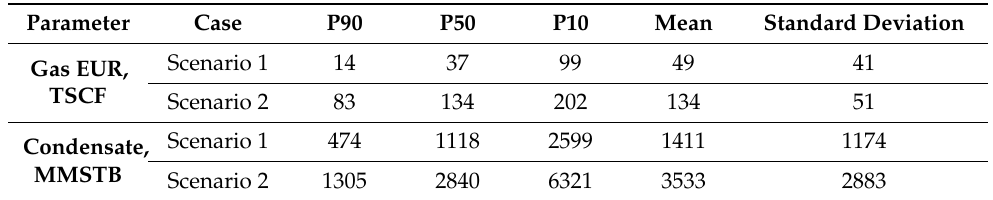
Table 8. Probabilistic EUR estimations for the 5153 Sections (see Section 2.9) covered by the Jafu- rah Field. Figure 12. Recovery factors of Scenario 1 for ( a ) oil and ( b ) gas, and recovery factors of Scenario 2 for ( c ) oil and ( d ) gas.